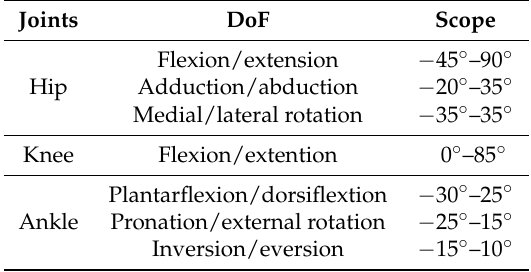
Table 1. Joints ranges of